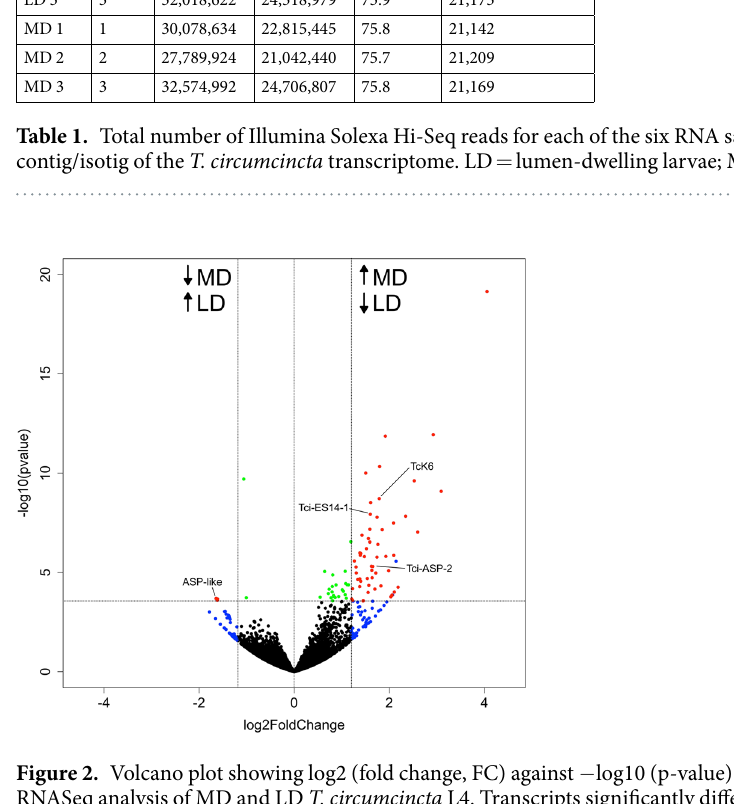
54 were up-regulated and three were down-regulated in MD larvae, and Fig. 2 shows a volcano plot of log 2 (fold change) against − log 10 (p-value) for the entire T. circumcincta dataset, highlighting the bias towards increased gene expression within the MD larvae samples. Of the differentially expressed transcripts, 23/54 of the MD up-regulated and 3/3 MD down-regulated transcripts had significant BLASTx hits (Table 2). In addition, 43 of the differentially expressed transcripts were homologues of genes present within the T. circumcincta genome assembly, PRJNA7256 (Table 2 and Supplementary Table S1). Up-regulated transcripts in MD larvae included five isotigs with homology to venom allergen/ASP-like proteins, five isotigs with homology to parasite proteases, one isotig (20922) with homology to a Stichodactyla helianthus toxin (ShKT)-related protein from the salmon louse Lepeophtheirus salmonis , and 12 isotigs with homology to parasite proteins of unknown function, of which nine were homologues of proteins pre- viously identified in ruminant nematode excretory-secretory (ES) products: five were homologues of a putative L3 ES protein from Ostertagia ostertagi (accession no. CAH23216.1) and four were homologues of a previously identified 15 kDa excretory/secretory protein of Haemonchus contortus (accession no. CDJ91363.1). Thirty-four (60.0%) of the differentially expressed isotigs possessed a signal peptide sequence. Relationships amongst those differentially-expressed molecules which had significant homologies to other molecules in public databases were inferred by alignment of the nucleotide sequences using ClustalX version 2.0.10, employing Neighbour-joining analysis and the resulting relationship tree constructed using TreeView is shown in Supplementary Fig. S1. This shows distinct groupings of related differentially-expressed, functionally related genes and that differentially regulated venom allergen/ASP-like transcripts segregate into four distinct clusters. Details of transcripts with no known homology are shown in Supplementary Table S1.